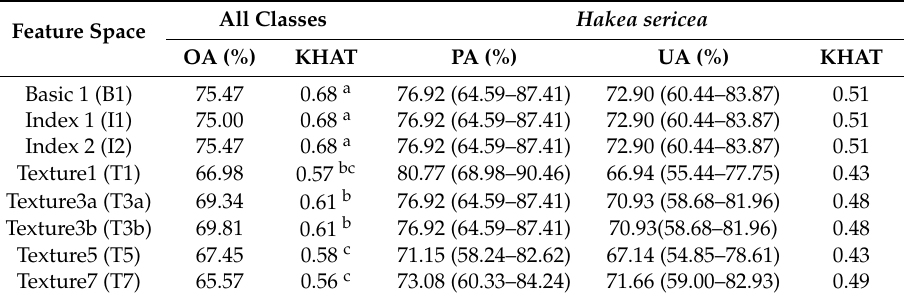
Table 4. General accuracy results for the UAV orthoimage study. OA, PA, and UA values are expressed in %. The Wald adjusted confidence intervals ( p < 0.05) are shown for PA and UA. Along the KHAT column, figures presenting different letters indicate significant differences for the KHAT statistic ( p < 0.05).